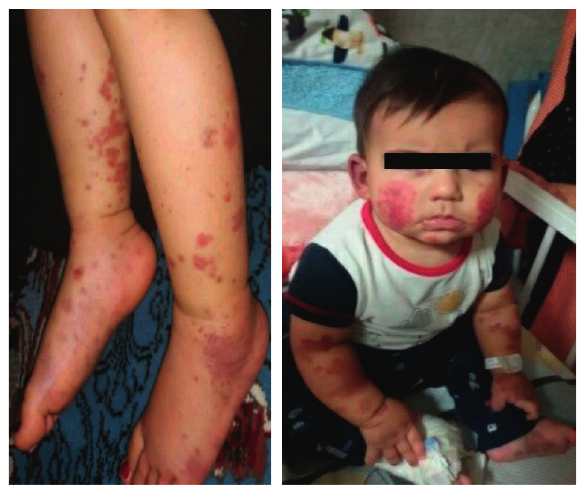
Figure 1: Extremity swelling and purpuric/ecchymotic lesions on the limbs and